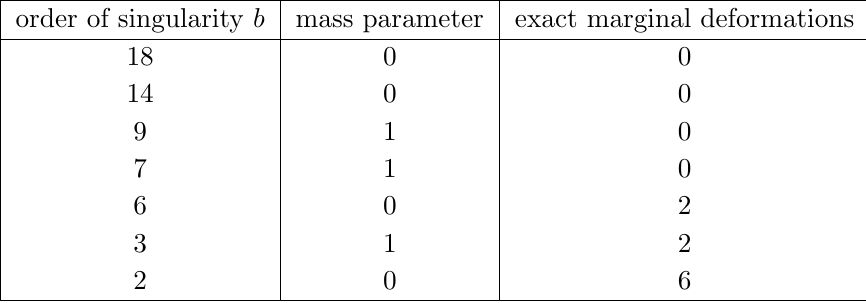
Table 5 . Summary of mass parameters and number of exact marginal deformations in E 7